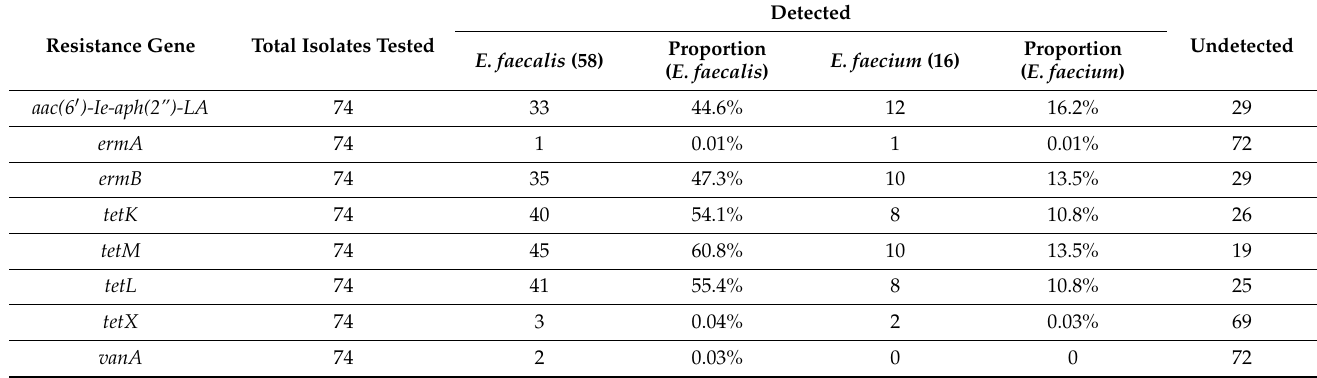
Table 6. The number of different resistance genes detected in E. faecalis and E. faecium isolates.